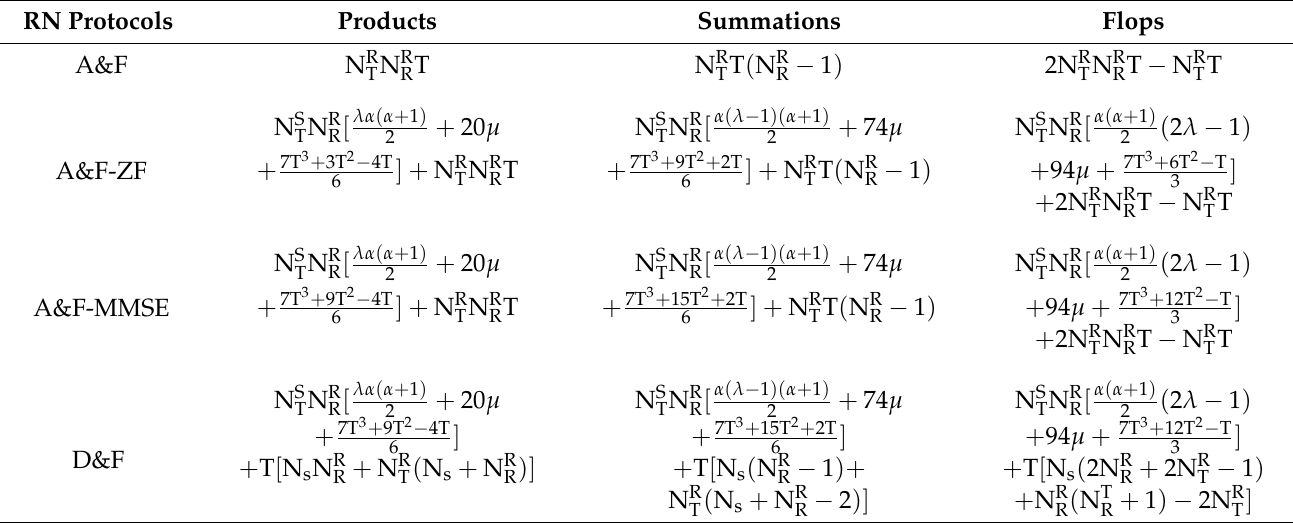
Table 2. Arithmetic operations required by Relay Node Protocols.